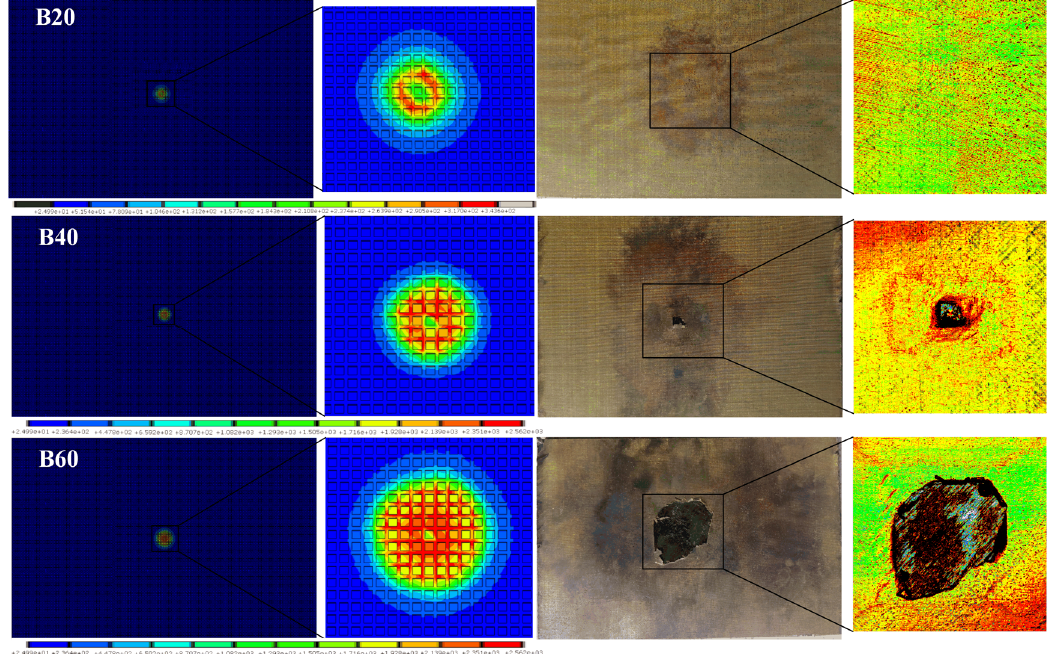
Figure 12. Results of Group B. Surface temperature field images of FEA, surface–subsurface superimposed temperature field images of FEA, specimen photos, and their ultrasonic C-scan images are shown from left to right.